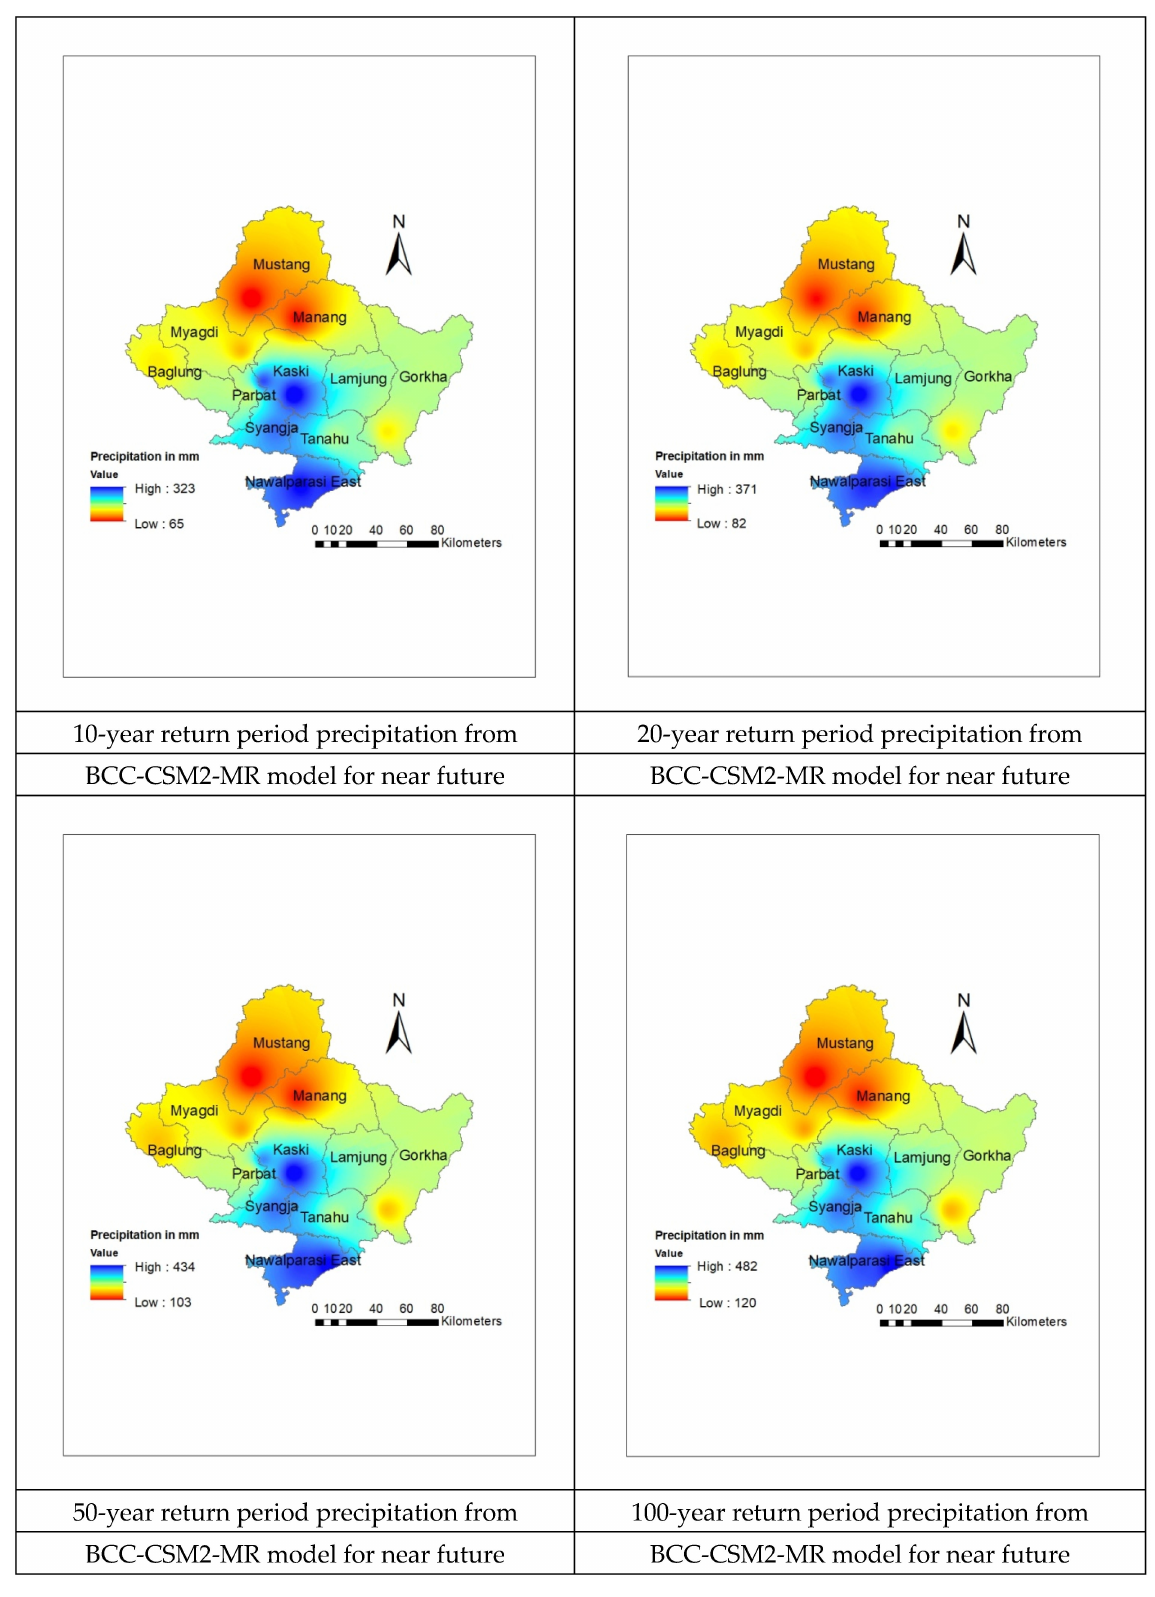
Figure A15. Cont